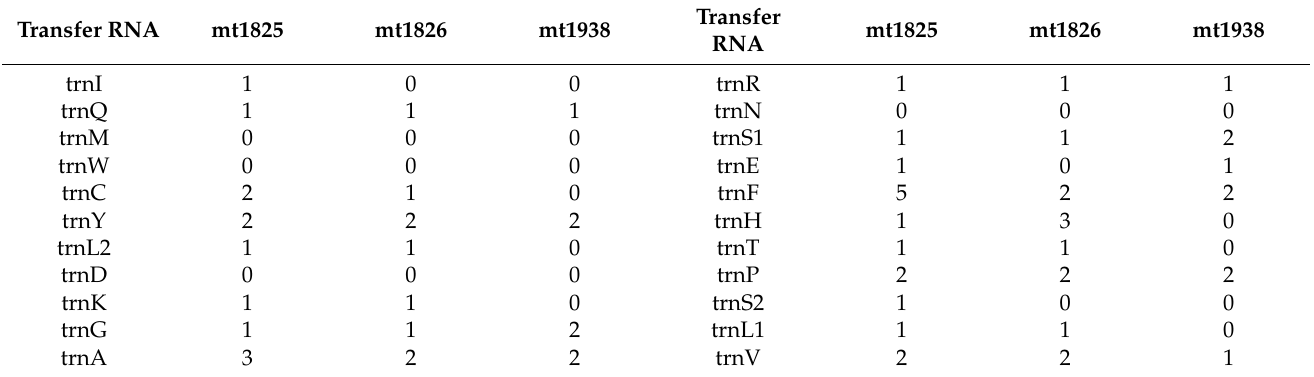
Table 4. Distribution of G–U base mismatches in tRNAs of the three newly sequenced